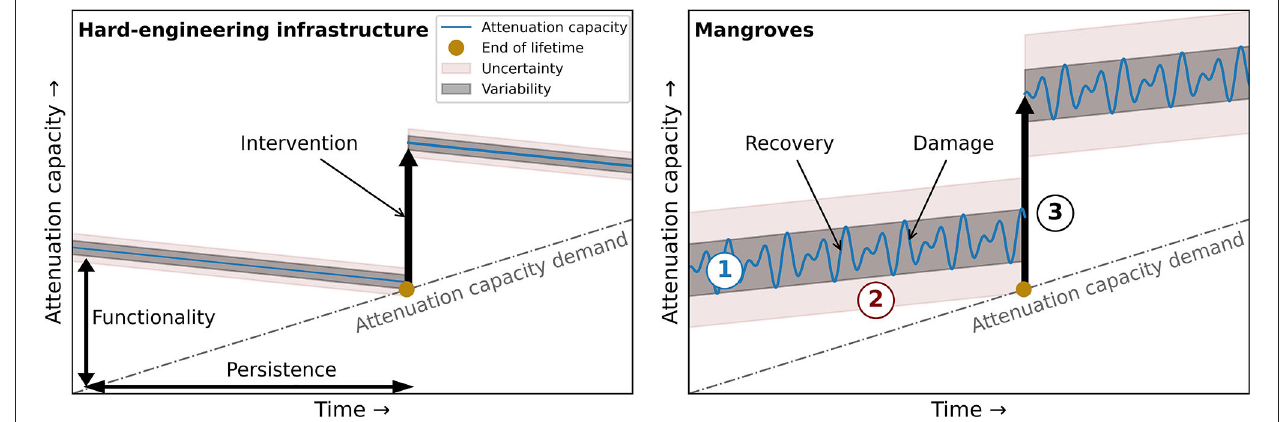
FIGURE 1 | Variability and uncertainty in reducing flood risk with (A) hard-engineering flood defences and (B) mangroves. The utilization of mangroves requires (1) insights in the variability of mangrove functionality and persistence, (2) tools to estimate and predict mangrove functionality and persistence and (3) design alternatives that increase mangrove functionality and/or persistence. The attenuation capacity demanded of flood protection infrastructure is expected to increase due to the globally increasing flood risk as a result of sea-level rise and increasing human activity in the coastal zone. While mangroves have capacities to adapt to sea-level rise (i.e., the attenuation capacity increases gradually), hard-engineering infrastructure cannot (i.e., the attenuation capacity gradually decreases). The figure scales depend on the local physical and social circumstances in specific flood risk projects.